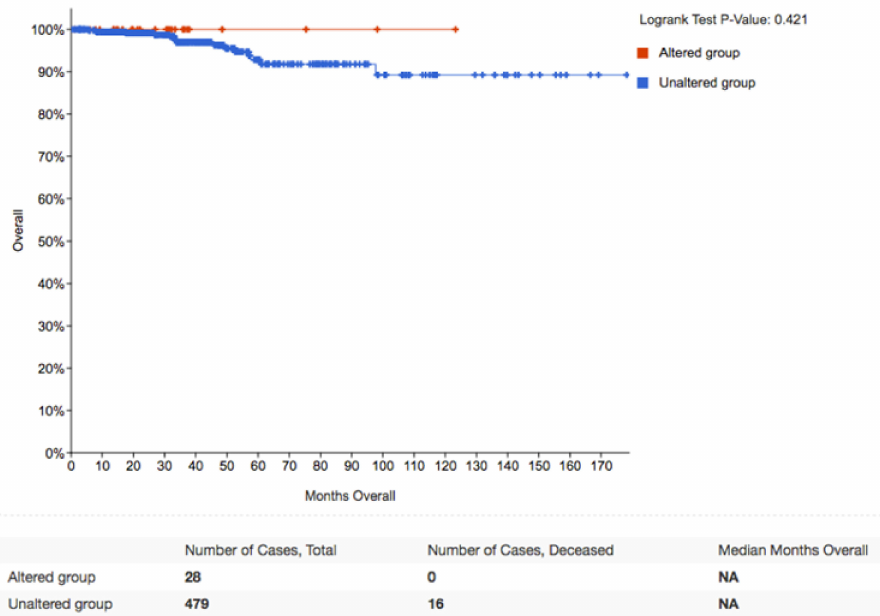
Figure 6. APT-1 levels determine the clinical outcome of thyroid tumors. Kaplan–Meier survival curve corresponding to genetic alterations in APT-1 (LYPLA1), HRAS, and NRAS in papillary thyroid carcinomas. Obtained from a cohort of 507 patients at cBioPortal for Cancer Genomics database